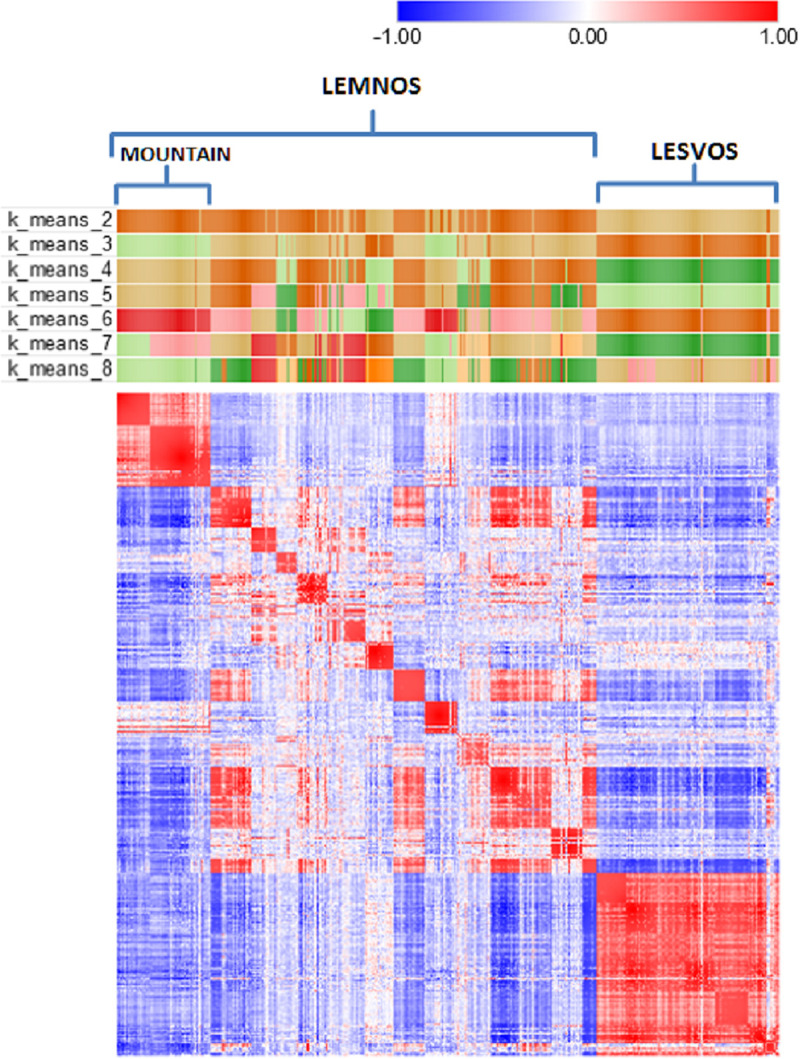
Heatmap of the genomic relationship matrix of 424 sheep from Lemnos and Lesvos along with k-means clustering (k = 2–8).The heatmap presents a color similarity matrix derived by Pearson moment correlations of the genomic relationships between pairs of individuals where red and blue colors indicate high (+1) and low (-1) genetic relationships, respectively. The presence of high intensity off-diagonal clusters indicates population structure. Small sized red colored squares on the diagonal denote high genomic relationships of animals at herd level. Large sized red colored squares at the upper left and lower right show the high genomic relationships of animals of the first three herds of Lemnos (mountain) and the six herds of Lesvos, respectively, that were grouped as separated clusters during k-means clustering.